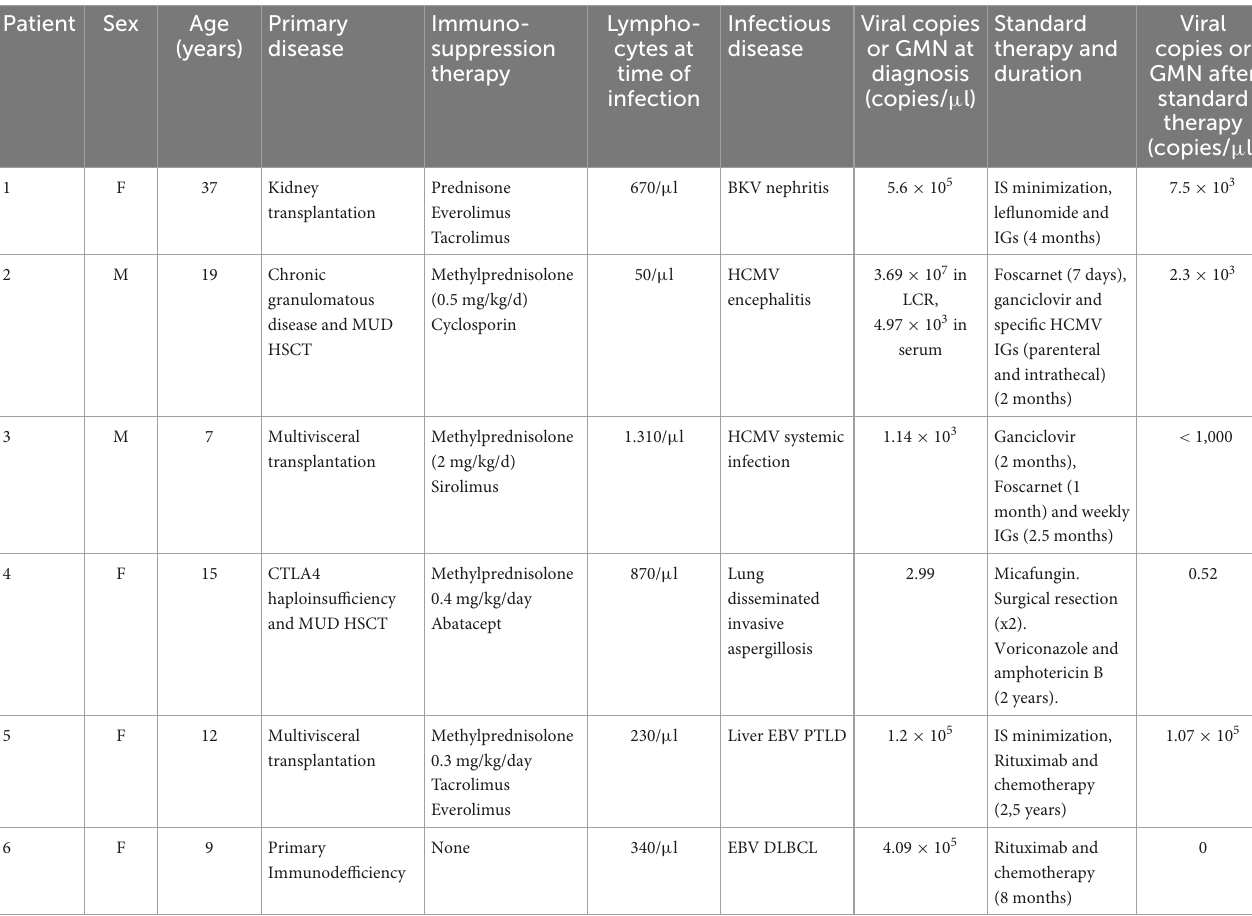
TABLE 1 Patient characteristics and pathogen-associated disease.